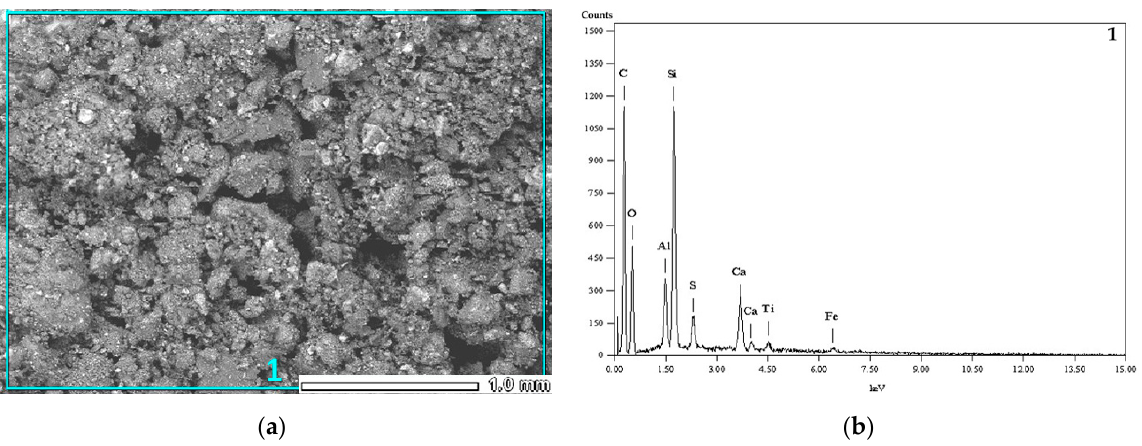
( d ) Figure 3. Dispersion energy spectra of X-rays (EDS) for individual nuggets (2, 3, 4) of brown coal, ( a ) photo of analyzed sample of brown coal; ( b – d ) spectra in points 2–4.